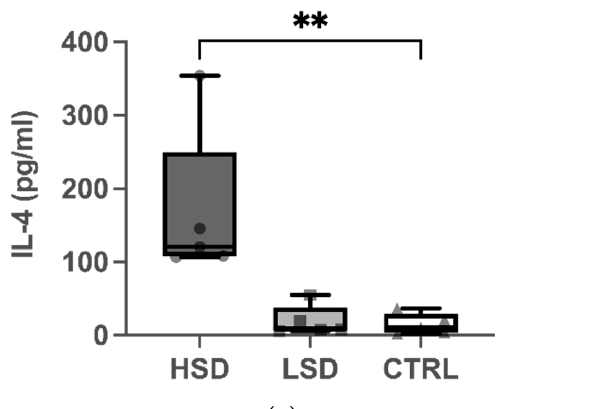
Figure 2. Effect of different concentrations of dietary sodium on the production of OVA-specific immunoglobulin G (IgG) ( a ), IgG1 ( b ), IgG2a ( c ), and IgE ( d ) antibodies in mice with OVA-induced food allergy. Serum was collected after challenge with the OVA antigen. IgG ( a ), IgG1 ( b ), and IgG2a ( c ) levels were examined by the enzyme-linked, immunosorbent assay (ELISA) and IgE ( d ) levels by the in vivo passive cutaneous anaphylaxis (PCA) test. Data are expressed as box-and-whisker plots with individual data points. The boxes represent the inner quartiles value range with the median indicated as black line. The whiskers represent minimum to maximum interval. * p < 0.05, ** p < 0.01, and *** p < 0.001. High-salt diet: HSD, Low-salt diet: LSD, Control diet: CTRL.